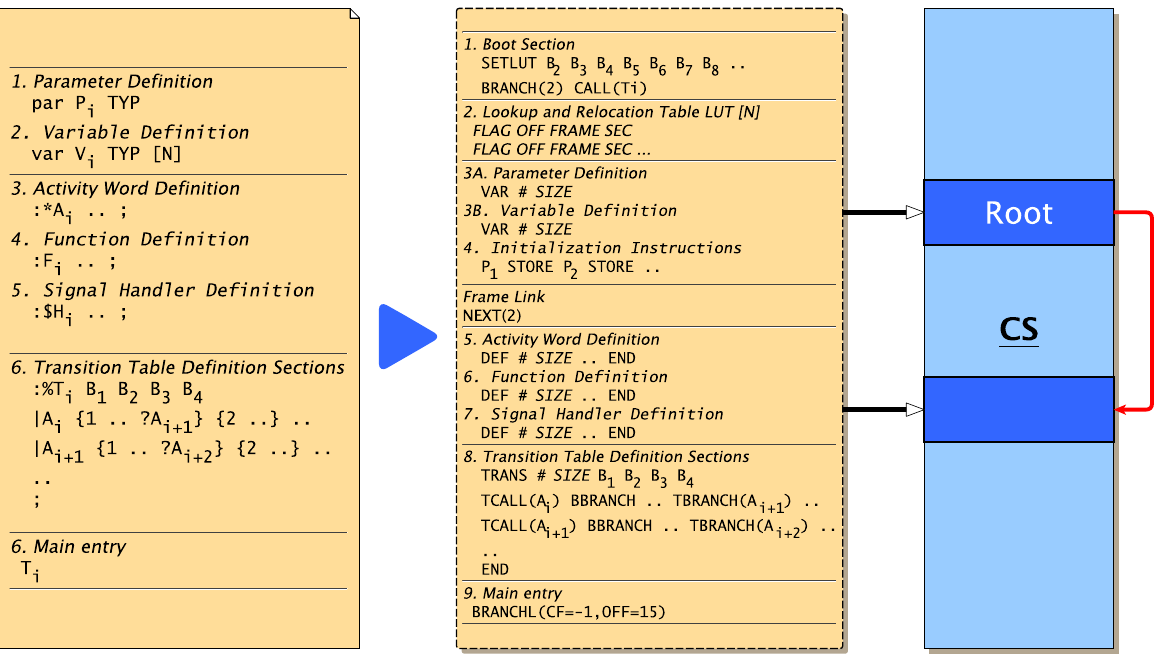
Figure 6. Logical code frame structure (( left ) Agent Forth Language (AFL) source code) and (optionally split) physical code frame (( middle ) Agent Machine Language (AML) machine code) with mapping to code partitions in the code segment ( right